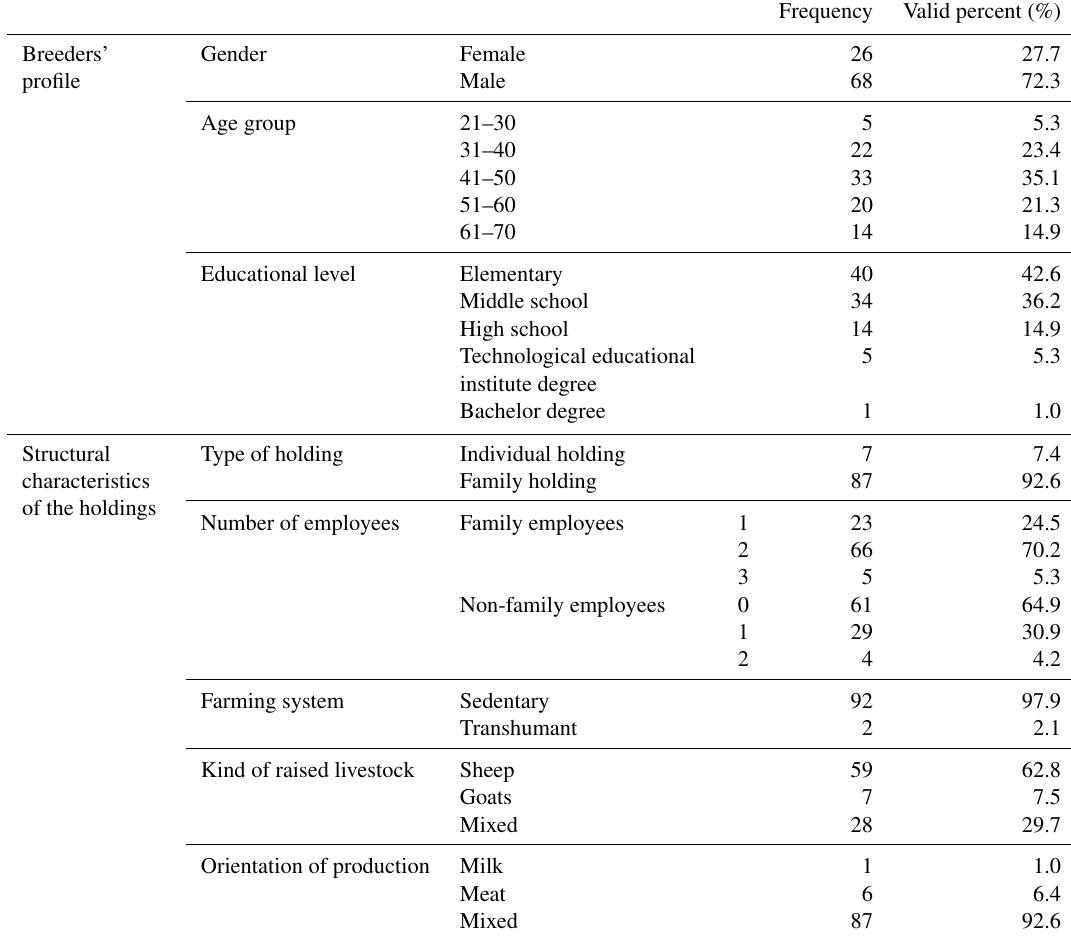
Table 1. Breeders’ profile and structural characteristics of sheep and goat holdings in the study